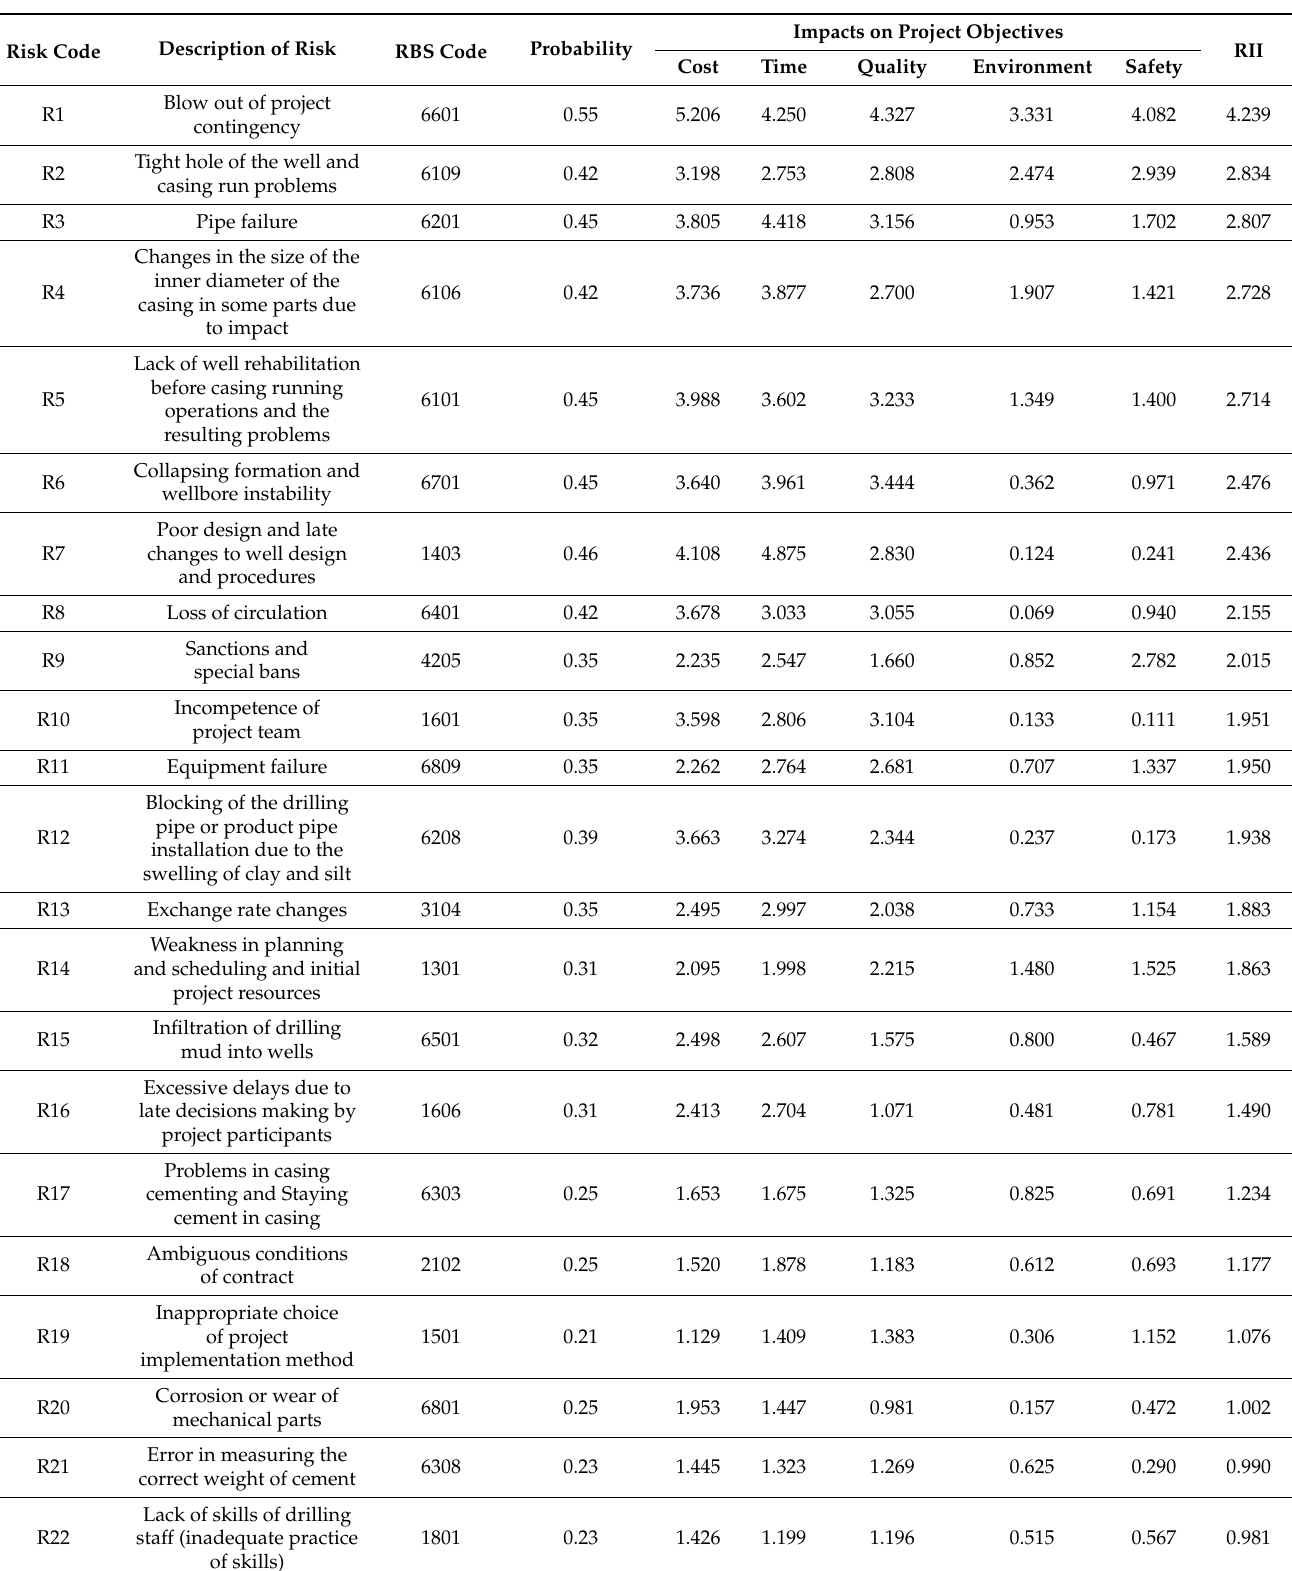
Table 2. The list of risks with the highest